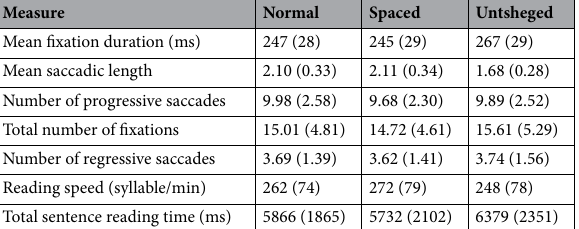
Table 2. Eye movement measures for the global analysis across conditions (standard deviations in